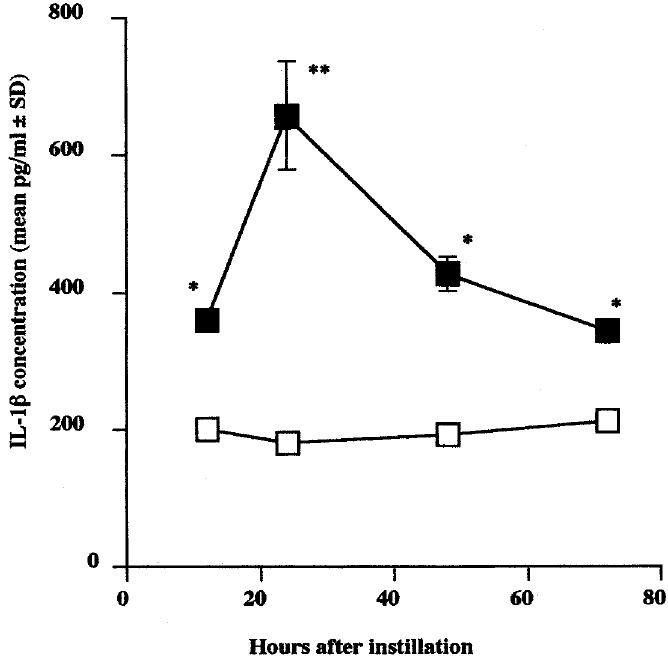
FIG. 4. Kinetics of IL-1 b appearance in ALE induced by intratracheal injection with 1.0 m g/ml LPS in a volume of 0.1ml. An ALE was prepared from five individual mice at different time intervals after intratracheal instillation. Each value represents the mean±SD of five individual mice of one of two different experiments with reproducible results. * P <0.05, ** P <0.001, h : PBS- instilled mice, j : LPS-instilled